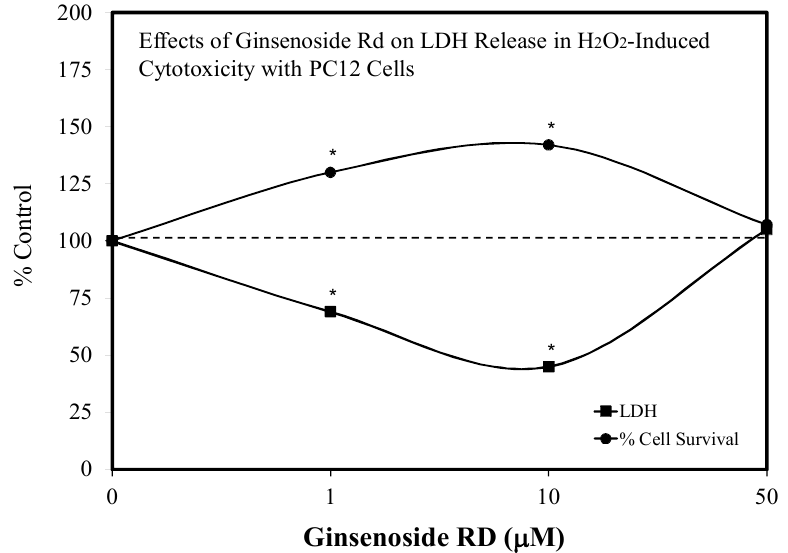
23 of 53 Figure 23. Effects of ginsenoside F2 on cell proliferation of hair growth cell models human hair dermal papilla cells (HHDPCs) and human keratinocyte cells (HaCaTs) concurrently treated with dihydrotestosterone (DHT) (which kills nearly 50% of cells via apoptosis in both cell lines) (Source: [94]). Each * represent statistical significance for a data point. 5.9. Ginseng-Rd There has been growing interest in the assessment of the principal constituents of ginseng. This section will address the ginseng constituent Rd and how some of its biomedical effects are mediated via hormesis. Interest in Rd originated with the findings of Yokozawa et al. [98–100], showing that Rd displayed antioxidant effects in kidney injury models of senescence-accelerated mice. These initial findings would stimulate research interest in Rd but with a particular focus on neuronal cellular systems starting with the work of Lopez et al. [101], showing that Rd decreased ROS formation in cultured astrocytes. 5.10. Stroke The first report of a hormetic dose response for Rd was made by Ye et al. [102] using PC 12 cells (Figure 24). In this study, the Rd was administered at the same time as the oxidant stressor, hydrogen peroxide. The Rd treatment displayed hormetic concentration responses for LDH release and cell